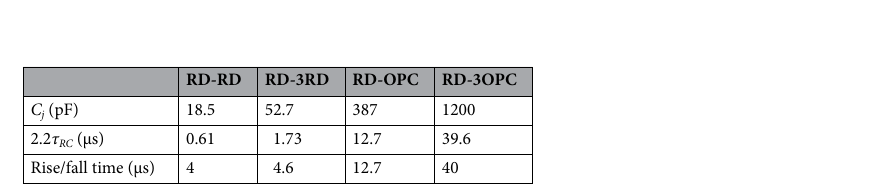
Table 8. Junction capacitance, RC time constant and rise/fall time of the